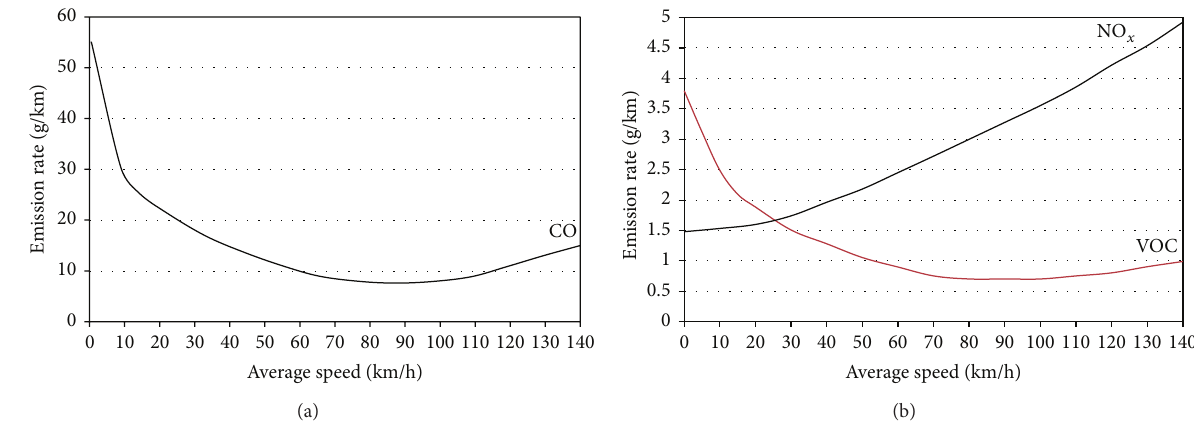
far. Therefore, the emission rates per mile are quite